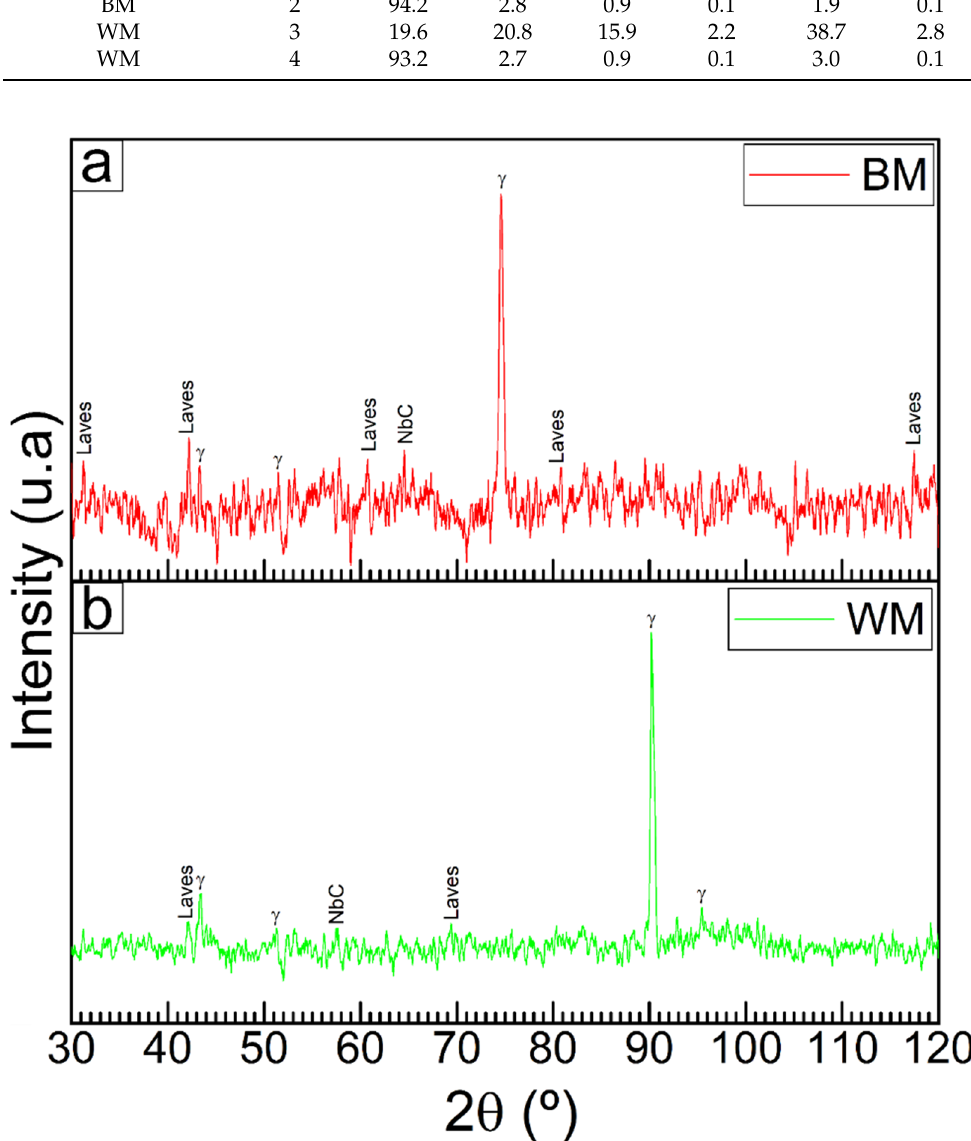
Figure 5. XRD patterns of distinct welding regions of the multi-pass shielded metal arc welded CW6MC butt joint: BM ( a ) and WM ( b ).